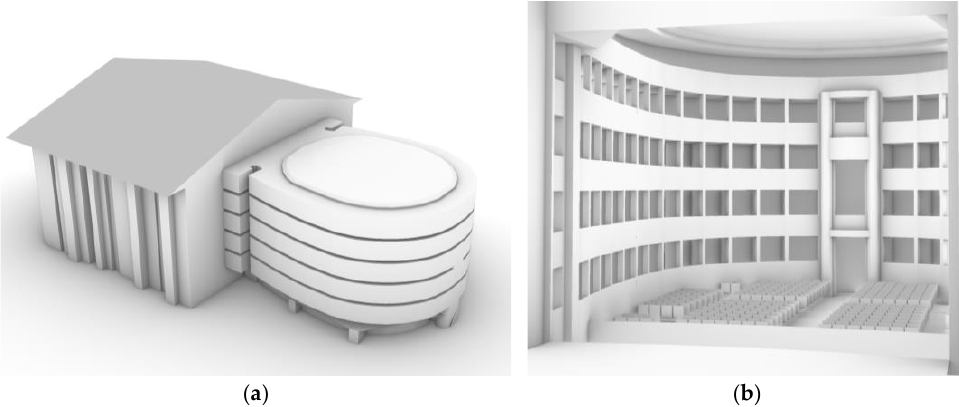
Figure 8. Digital model of the Ponchielli theater of Cremona: external view ( a ), perspectival view of the main hall from the stage ( b ).